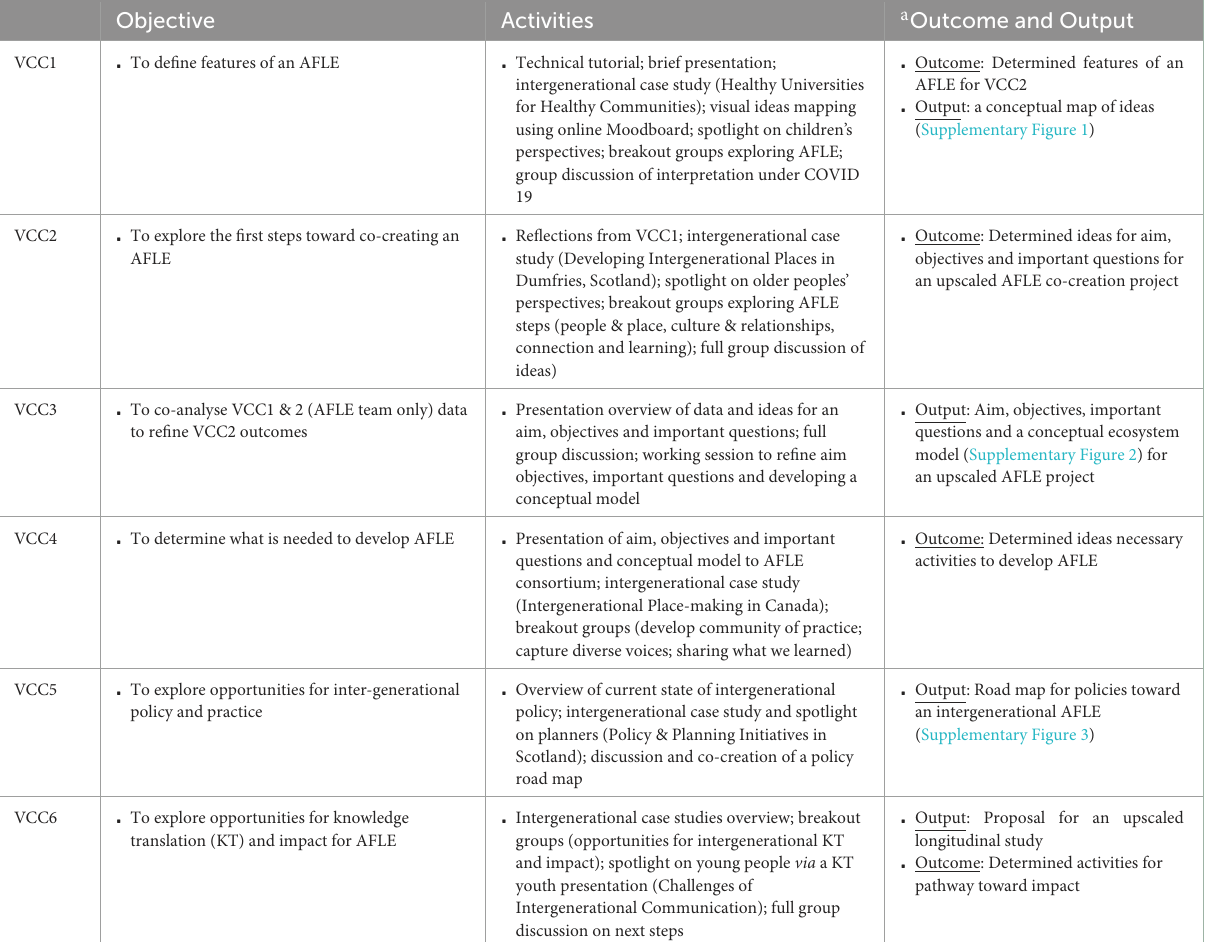
TABLE 2 Key objectives, activities and the resulting outcomes and outputs of the VCCs.